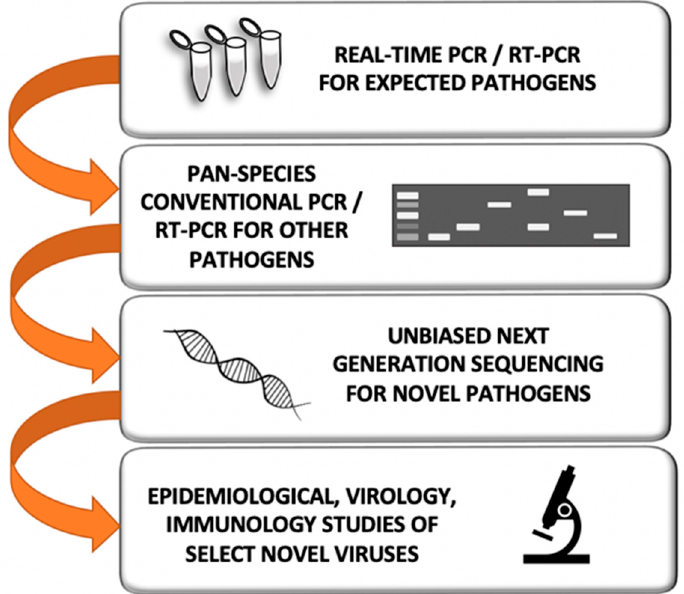
Figure 3. Flow diagram for field specimen study. Our international partners conduct most of the real-time RT-PCR/PCR screening work and some of the pan-species molecular work. If a virus is not yet identified but suspected, next-generation sequencing may be employed for pathogen discovery. Where we see evidence of the same respiratory viruses in both the animal workers and their animals, we next intensely study those viruses for their prepandemic potential. This may involve attempts at viral culture in multiple human and animal cells lines and full genome sequencing. If further risk assessment is warranted, this may involve seroepidemiological studies of other animal workers, the development of specific molecular assays for geographical prevalence studies, and pathogenesis studies in animal models.